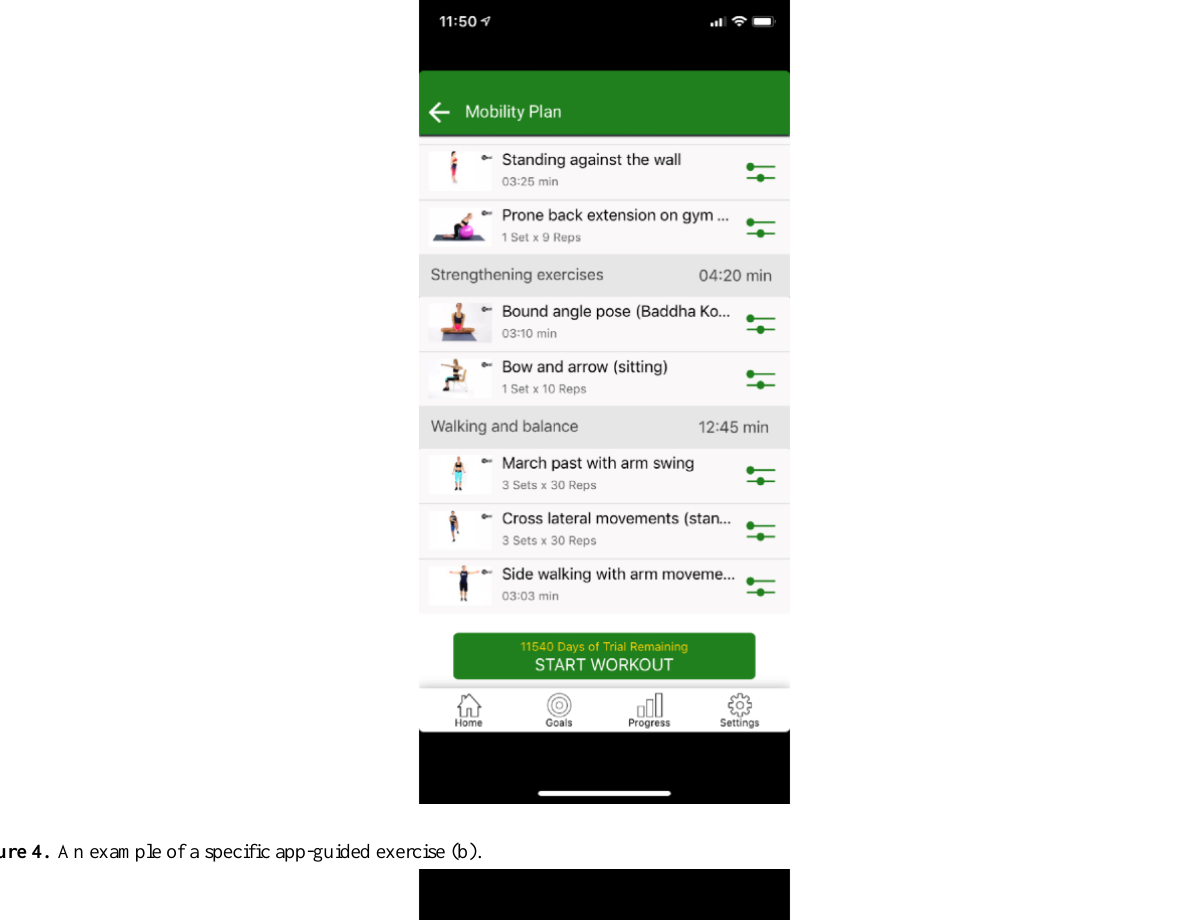
Figure 3. An example of an exercise program.